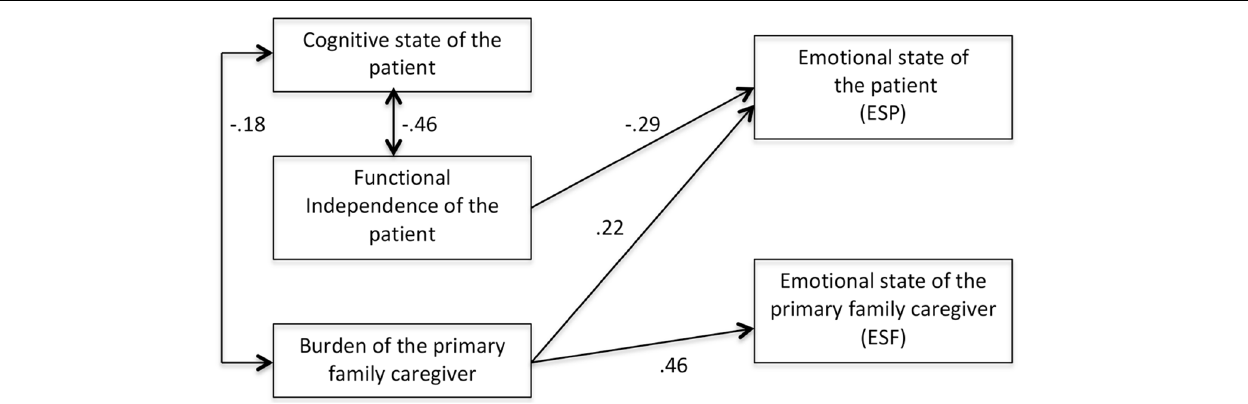
FIGURE 2 | Final model estimated in the sample of patients without cognitive